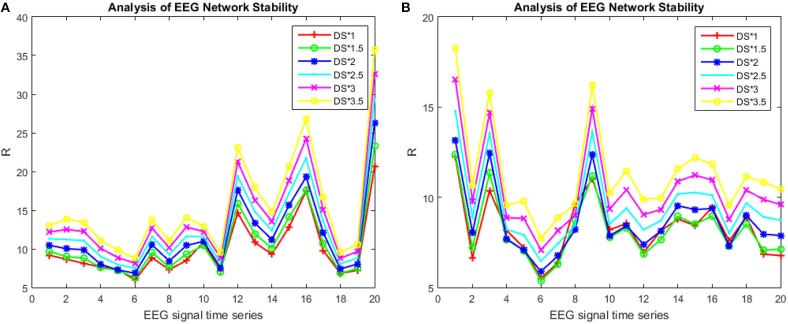
R-value changes with the strength of the S area in patients and healthy controls. The patient subject graphed here was #6 in (A) and the healthy control subject was #4 in (B).